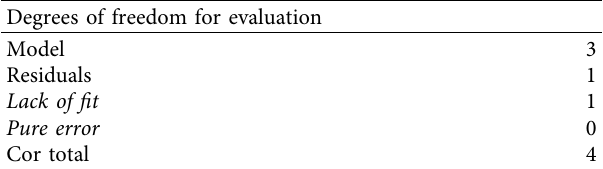
Table 2: Design matrix evaluation.